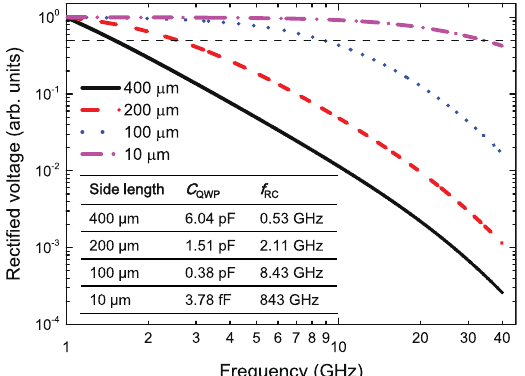
Figure 4. Modelling of rectified voltage for terahertz QWPs with different dimensions. Calculated rectified voltage as a function of frequency upto 40 GHz for different mesa side lengths. For clear comparison, the rectified voltage is normalized. The horizontal dashed line shows the 3 dB attenuation power level. The inset gives the QWP capacitance C QWP calculated using a parallel-plate approximation and the R-C roll-off frequency f RC = 1/(2 π R L C QWP ) for a load resistance R L = 50 Ω for different side